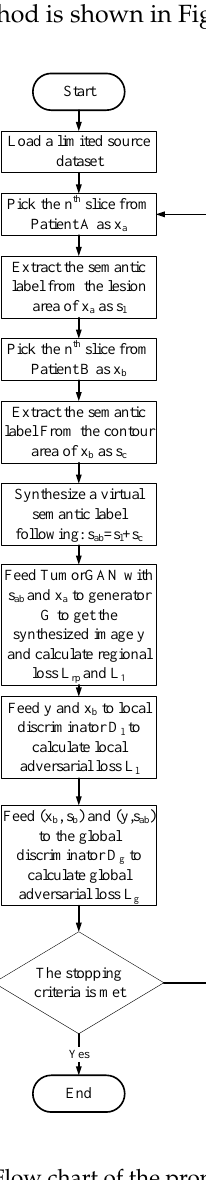
Figure 4. Flow chart of the proposed